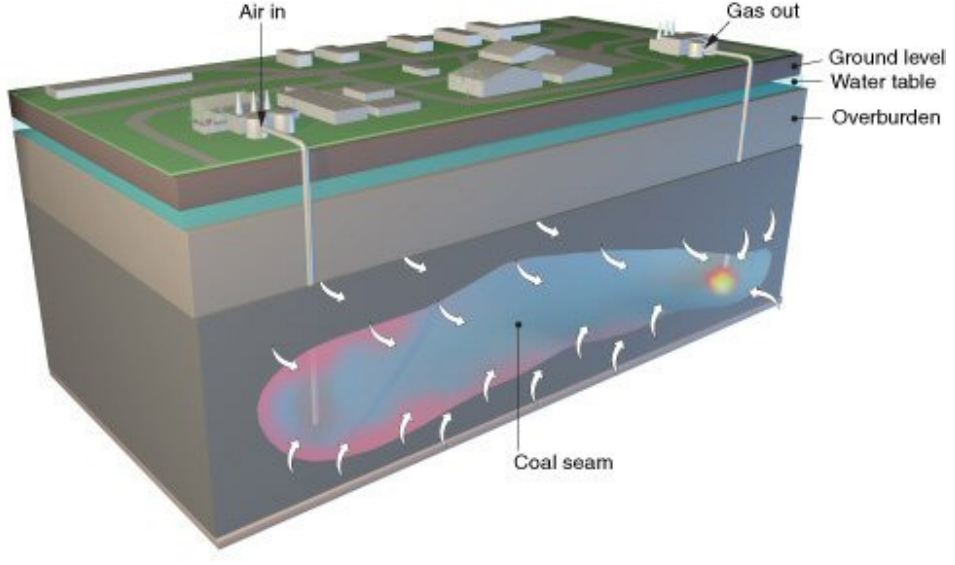
Figure 1: Schematic of the UCG process (linked vertical wells method), with water entering from the surrounding rocks